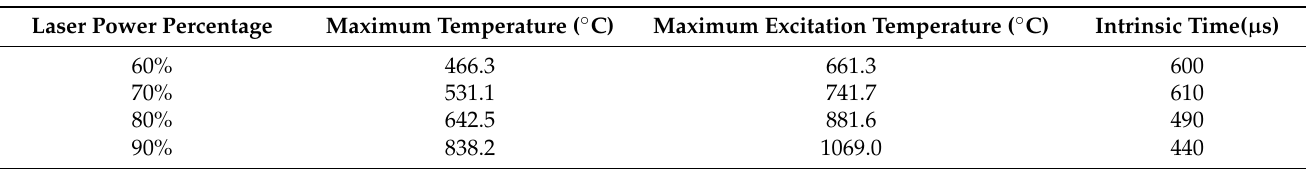
Table 4. Time constants of thin-film thermocouple at different laser power.